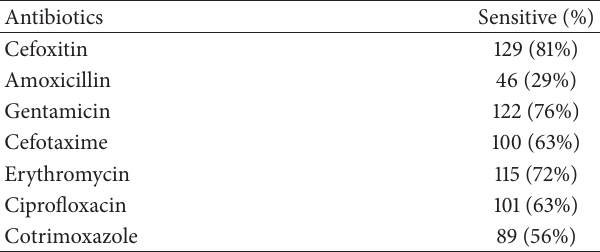
Table 4: Antibiotic susceptibility patterns of Pseudomonas aerugi- nosa ( 𝑛 = 45 ).